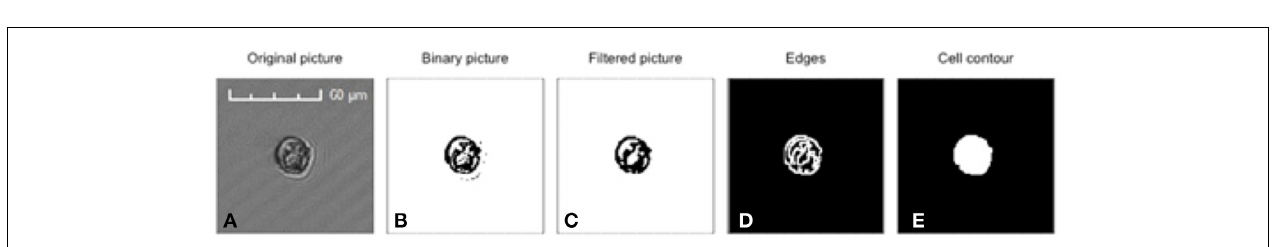
Frontiers in Microbiology | Systems